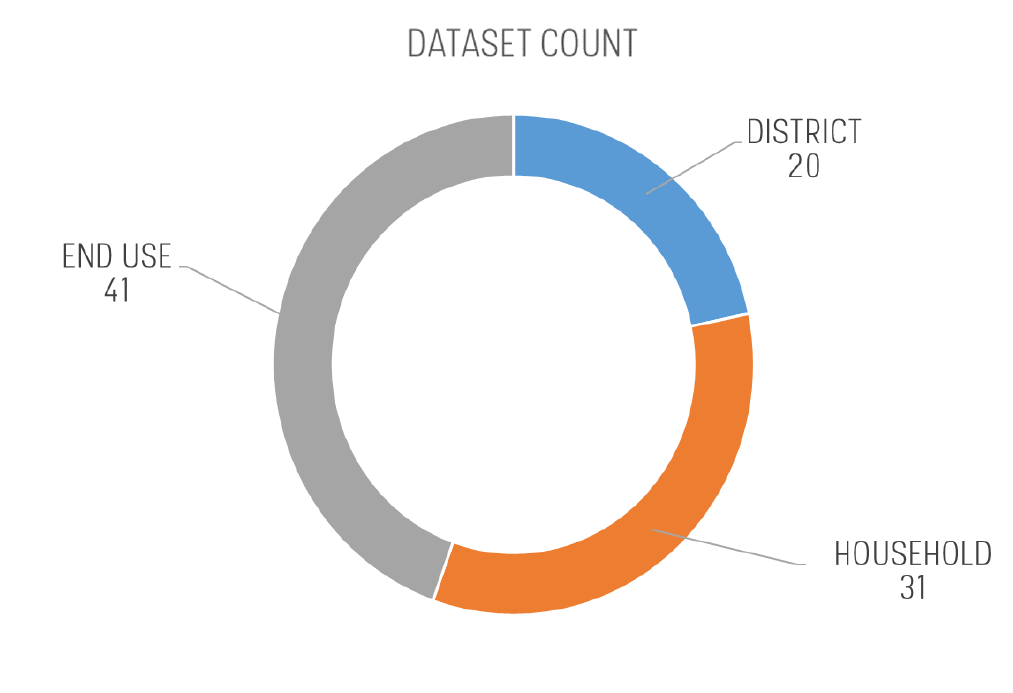
Figure 2. Distribution of the 92 reviewed datasets across three spatial scales, i.e., district, household, and end